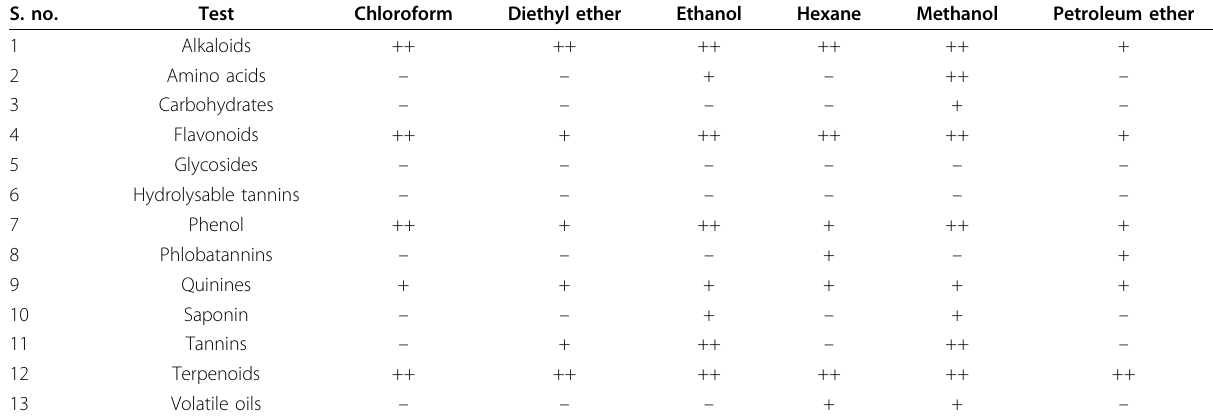
Table 3 Phytochemical screening of A. nilagirica extracts S.